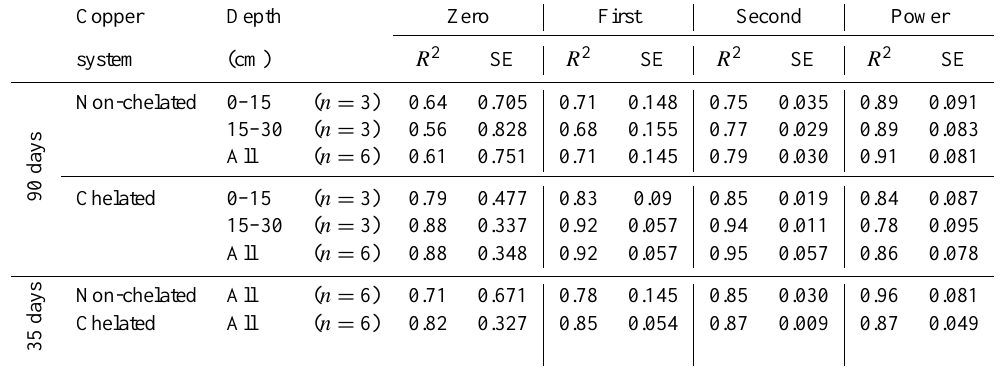
SE: standard error of regression